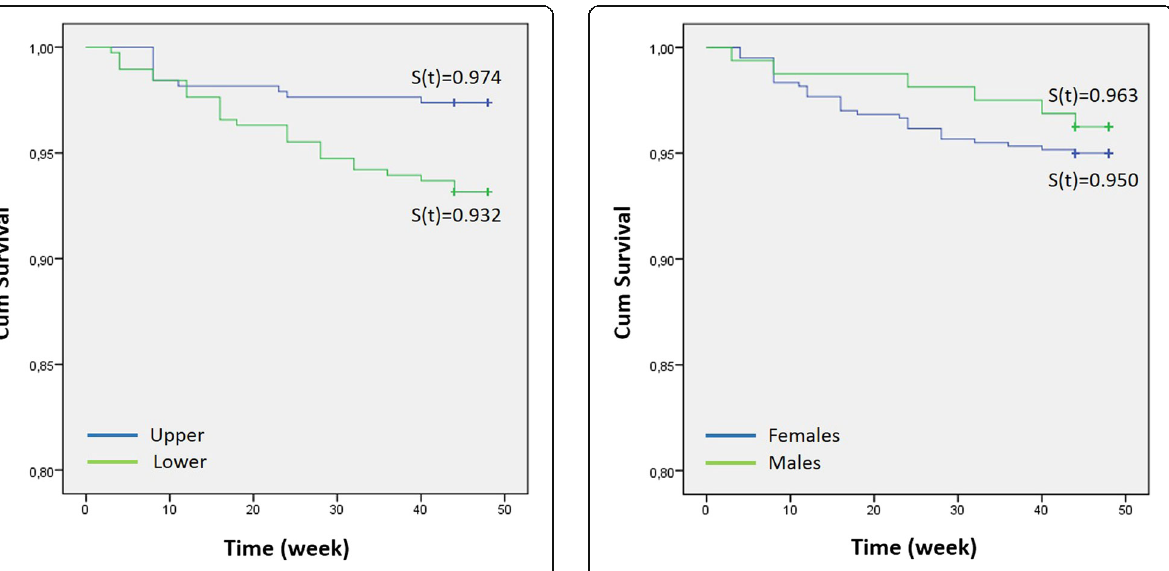
Fig. 4 Bracket survival distribution for dental arches Fig. 5 Bracket survival distribution for female and male patients